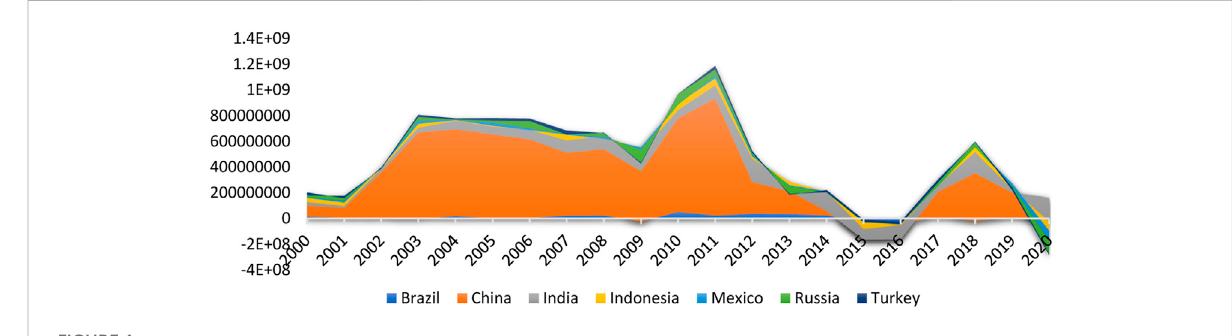
FIGURE 1 CO ₂ emissions yearly change. Source: Author ’ s